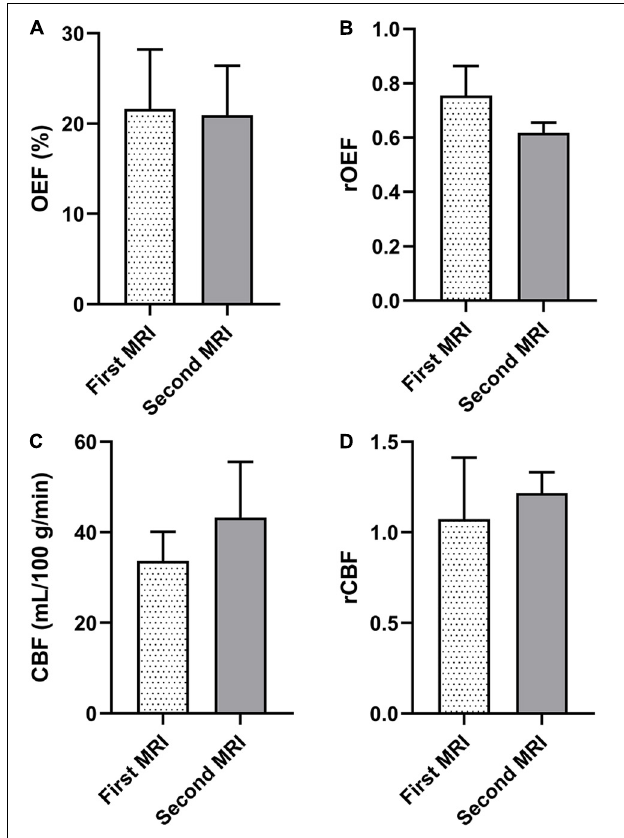
FIGURE 7 | Parameters of the ischemic lesions between the longitudinal MRI scans in four patients whose IDL is of equal volume to the FI. (A) OEF. (B) rOEF. (C) CBF. (D) rCBF. OEF, oxygen extraction fraction; rOEF, relative OEF; CBF, cerebral blood flow; rCBF, relative CBF; IDL, initial diffusion lesion; FI, final